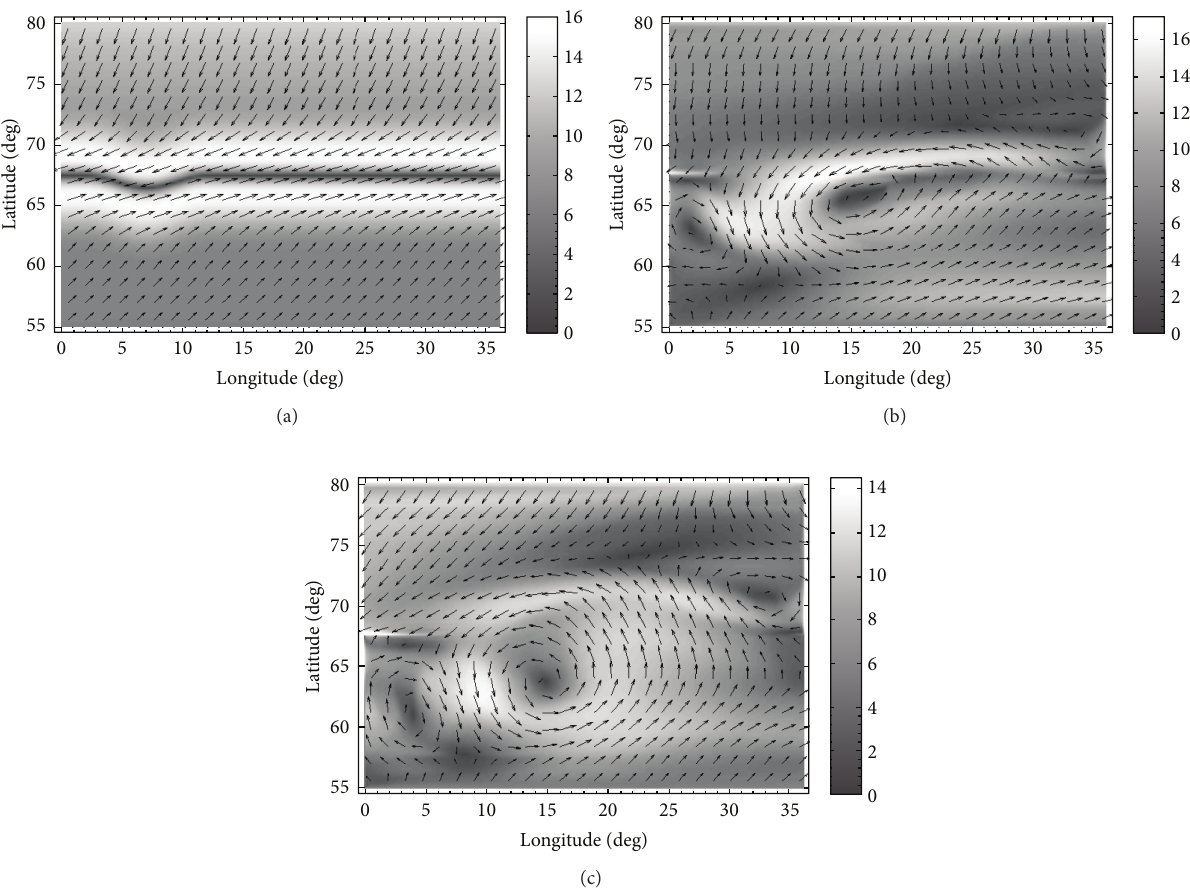
Figure 1: The distributions of horizontal component of the air velocity at the altitude of 600 m, assigned at the initial moment (a), computed 20 hours after the beginning of calculations (b) and computed 40 hours after the beginning of calculations (c). The results are obtained for the first initial configuration of the arctic front, with the fields of the module of the horizontal velocity being approximately symmetric relatively to the centerline of the arctic front. The degree of shadowing of the figures indicates the module of the velocity in